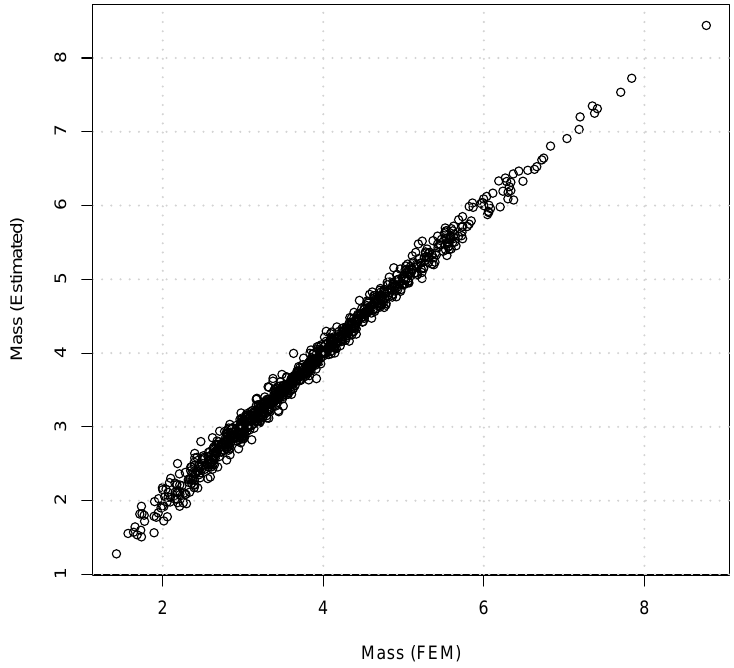
Figure 10. Mass values computed by FE and the